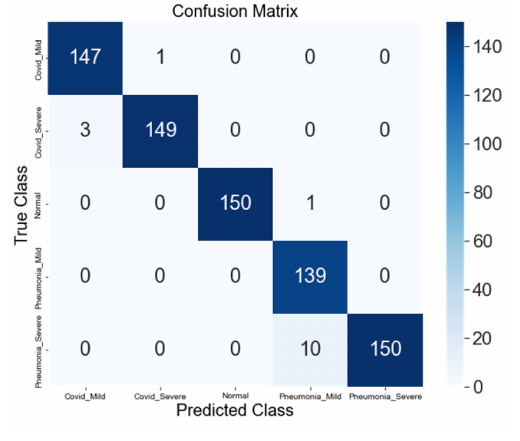
Fig. 9 Predicting matrix (five